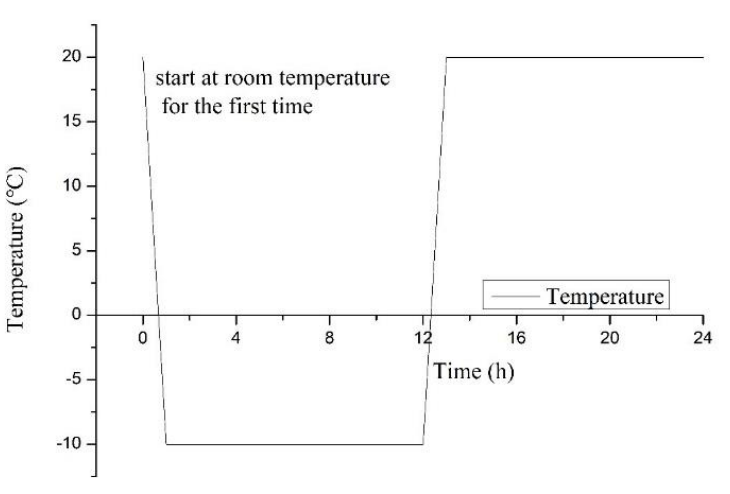
Figure 3. Temperature curve of a F-T